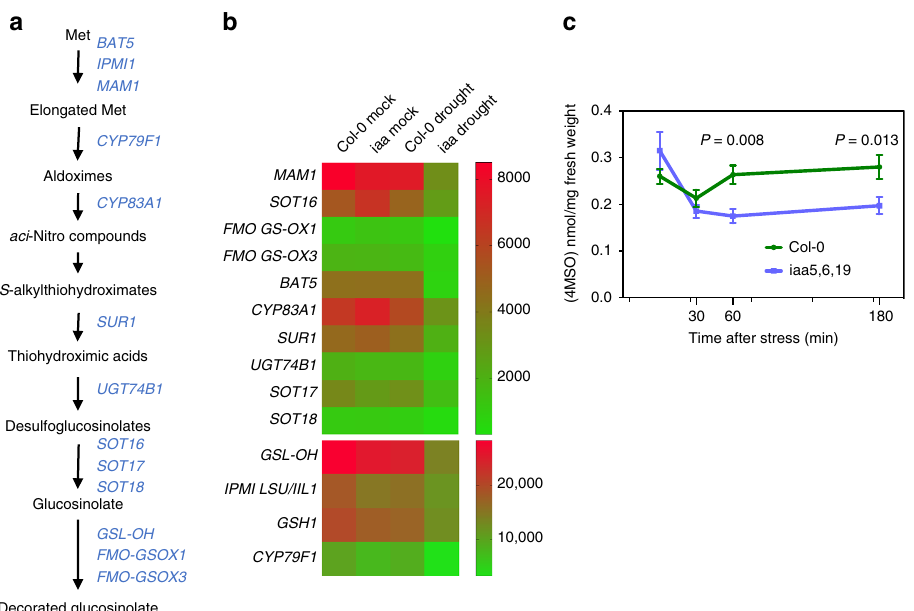
Fig. 1 The iaa5,6,19 mutant has lower aliphatic glucosinolate levels after dehydration stress. a Aliphatic glucosinolate biosynthetic pathway. The genes listed to the right are all down-regulated in the triple mutant compared to the wild type after dehydration. b Heat map showing that aliphatic glucosinolate biosynthetic genes are down regulated in the iaa5,6,19 mutant during desiccation stress. c Time course measurement of 4-MSO levels in 7-day-old seedlings of indicated genotypes at time intervals after application of dehydration stress. Results are presented as the means ± SE of one experiment with 6 biological replicates consisting of n = 20 pooled seedlings in each. Two independent experiments showed similar a trend. Statistical signi fi cance was determined by (Student ’ s t- test). P = 0.008 and 0.013 respectively for iaa5619 at 60 and 180 min of desiccation. Source data are provided as a